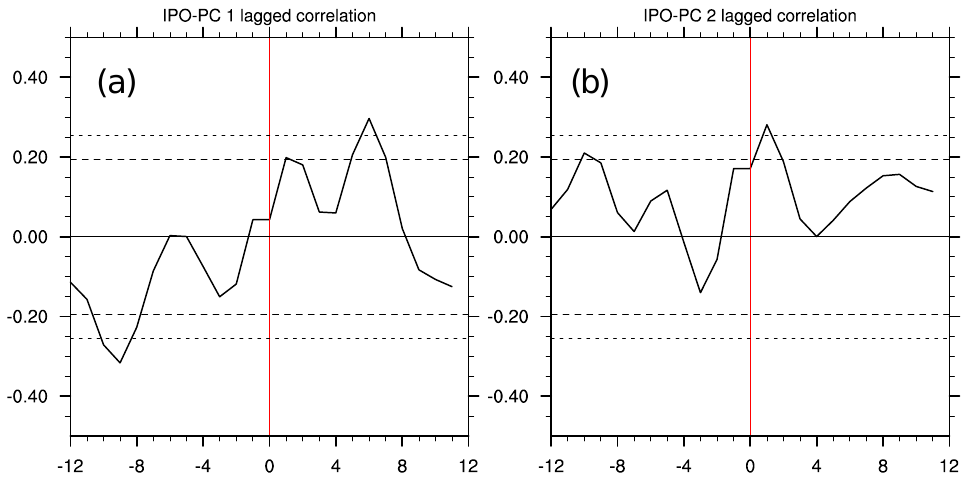
Figure 6. Lagged correlation of PC1 ( a ) and PC2 ( b ) with a four-year low-pass filtered IPO. Dashed lines denote significant correlation at 95% and 99% confidence levels.